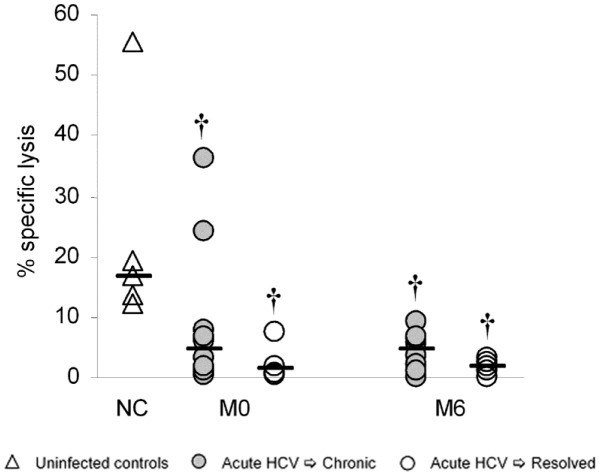
Functional competence of NK cells in acute HCV infection.Natural Cytotoxicity of bead-purified NK cells is compromised both early (M0) and late (M6) in acute HCV infection irrespective of outcome. * p<0.05 chronic versus resolved; † p<0.05 versus uninfected control (MWU) Abbreviations: NC = normal control; M = month.